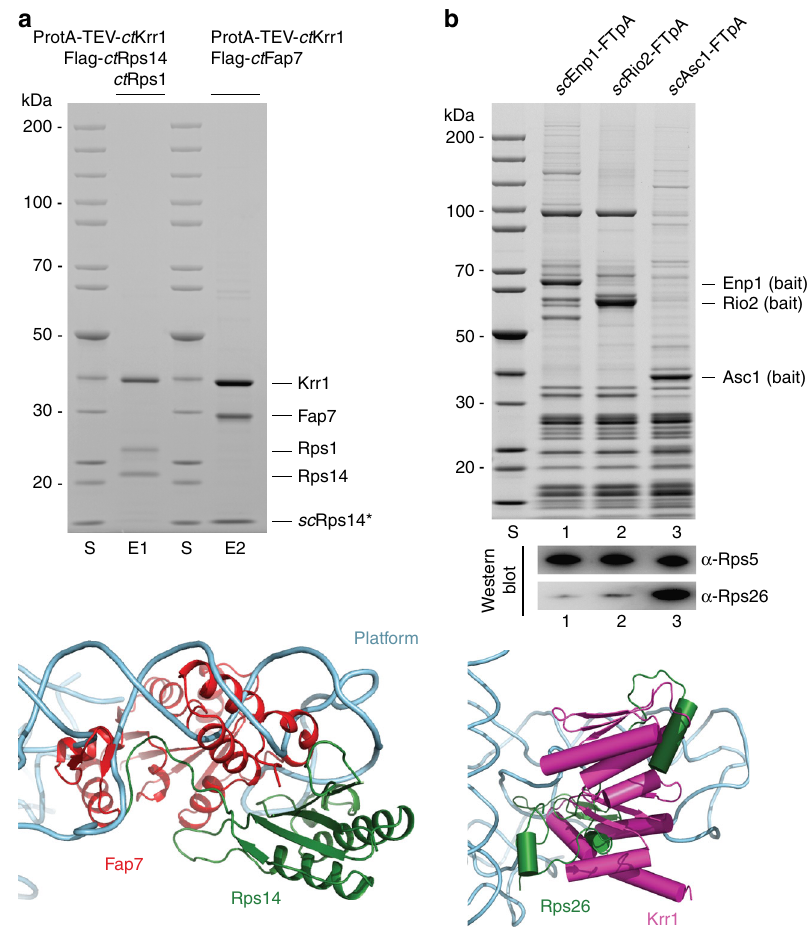
Fig. 4 Interaction network of Krr1 on the 90S pre-ribosome. a ct Krr1 forms a complex with ribosomal proteins Rps14 and Rps1. The indicated heterotrimeric ct Krr1- ct Rps14- ct Rps1 and hybrid complex ct Krr1- ct Fap7- sc Rps14, which includes the endogenous yeast ribosomal protein Rps14, were assembled by co- expression of the indicated Chaetomium thermophilum factors in yeast followed by split-tag tandem af fi nity-puri fi cation. The reconstituted complexes were analyzed via SDS-PAGE (4 – 12%) and Coomassie staining. The labeled protein bands were identi fi ed by mass spectrometry. The depicted crystal structure of Fap7 (red) bound to Rps14 (green) (lower panel) shows how Fap7 binding clashes with binding of Rps14 to rRNA helix 23 (light blue) within the 90S pre-ribosome. Superimposition was carried out based on the Rps14 proteins from both the isolated platform of the 90S pre-ribosome (PDB: 5JPQ) and the crystal structure of the Rps14-Fap7 complex (PDB: 4CW7). For better visualization, only the crystal structure of Rps14-Fap7 and the rRNA of the platform were shown in cartoon representation. b Binding of ribosomal protein Rps26 clashes with the Krr1 binding site on the 90S particle. Tandem af fi nity- puri fi cation of FTpA-tagged Enp1, Rio2 and Asc1. Eluates were TCA-precipitated and analyzed by SDS-PAGE (4 – 12%) and Coomassie staining (upper panel) or western blotting (lower panel) using indicated antibodies. The lower panel shows a superimposition of Rps14 proteins from both the isolated platform of the 90S pre-ribosome (PDB:5JPQ) and the crystal structure of the mature 40S (PDB: 4V5O). For a better visualization, only Rps26 (green), Krr1 (pink) and the rRNA (blue) of the 40S platform were depicted in the cartoon representation. The experiments were performed at least twice with consistent results. Uncropped images are shown in Supplementary Fig. 9. S molecular weight protein standard, E1 and E2 eluates 1 and